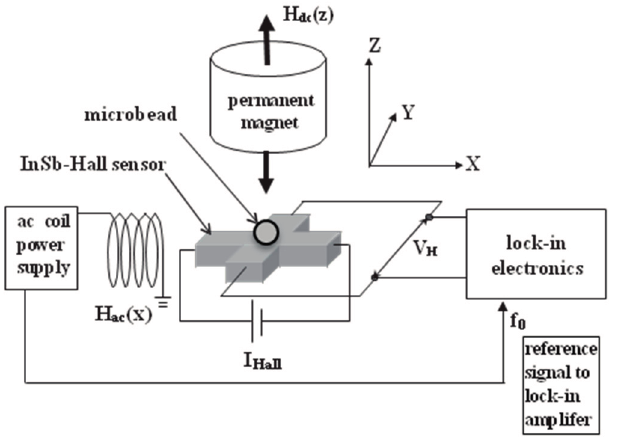
Figure 1. The system for detecting magnetic particles with a Hall sensor. Adapted from